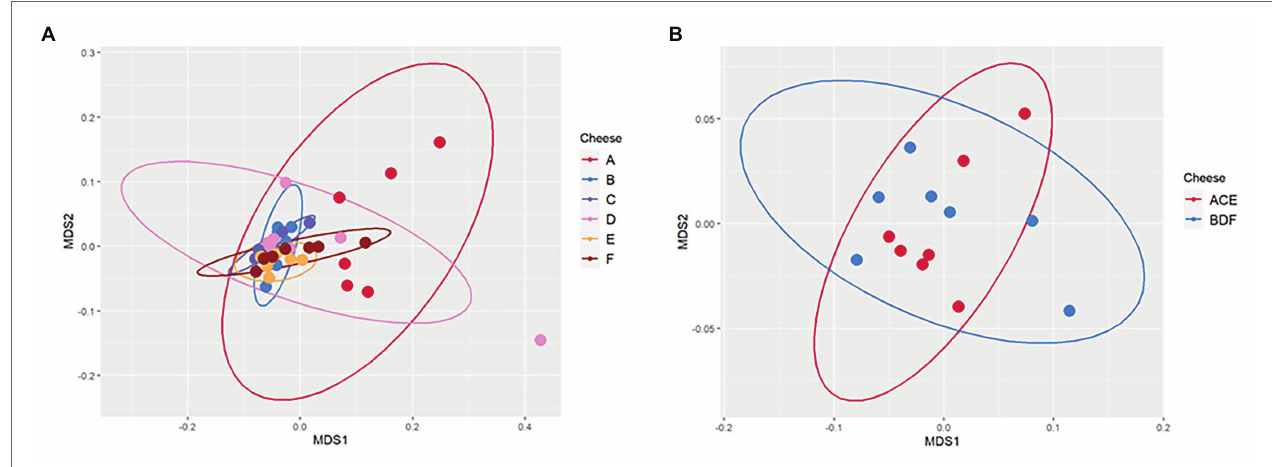
FIGURE 5 | Principal Component Analysis Plot (PCA) using Bray Curtis distance matrix to measure beta diversity of (A) the six individual Gouda cheeses (A, B, C, D, E, and F) and (B) the two types of Gouda cheeses (ACE, uninoculated and BDF, inoculated) manufactured in this study.